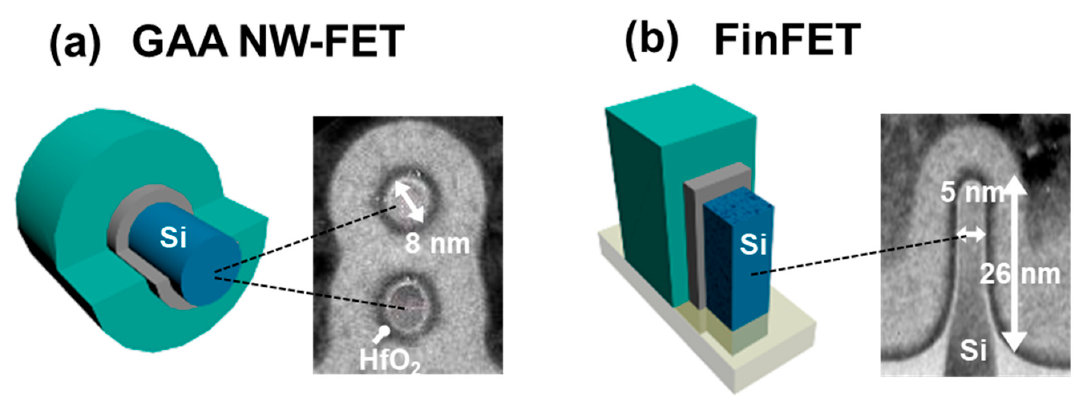
Figure 1. TEM cross-sectional images of NMOS: ( a ) gate-all-around nanowire field effect transistors (GAA NW-FETs); and ( b ) fin field effect transistors (FinFETs). Two nanowires are stacked in GAA NW-FETs.